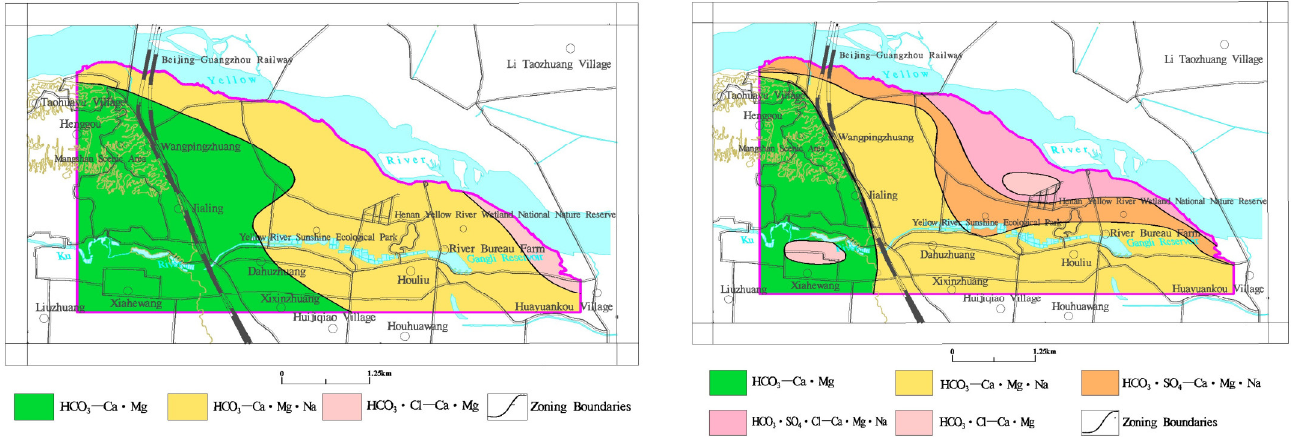
Figure 10. Spatial distribution map of groundwater chemical types in the study area. (( Left )—1990, ( Right )—2020).